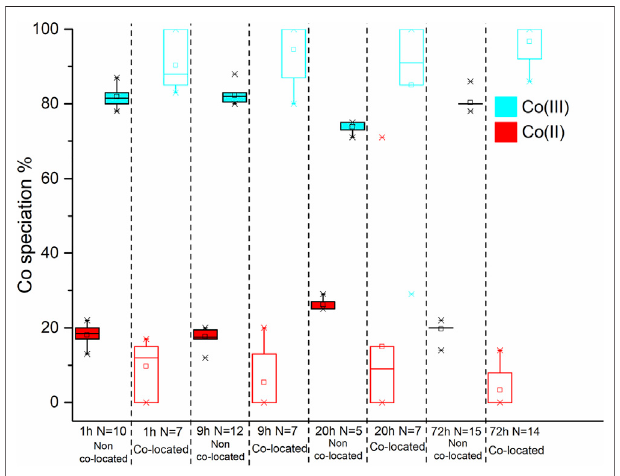
FIGURE 9 | Box and whisker plot diagrams showing the changes in Co speciation over the course of the experiment. The box and whisker plots for the starting material have adotted outline.The box and whisker plots from the non co-located regions have a solid black outline while those from the co-locatedregionshavecolouredoutline.InbothspatialregionstheCo(III)and Co(II) data is represented with red and blue,